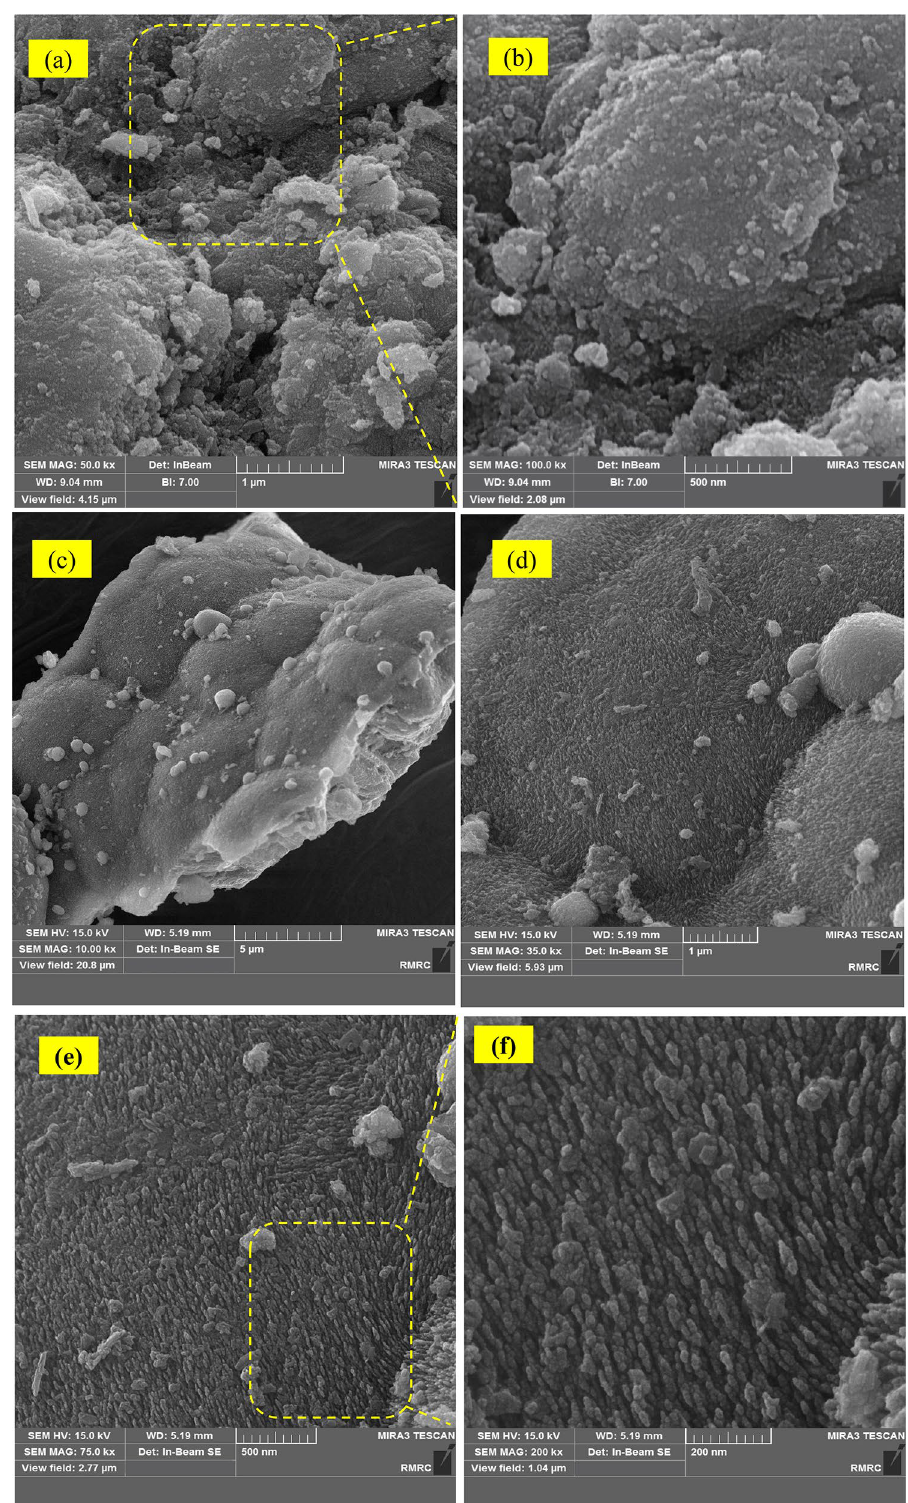
Figure 4. FESEM micrographs of ( a , b ) NL samples and ( c – f ) PTL/Ar